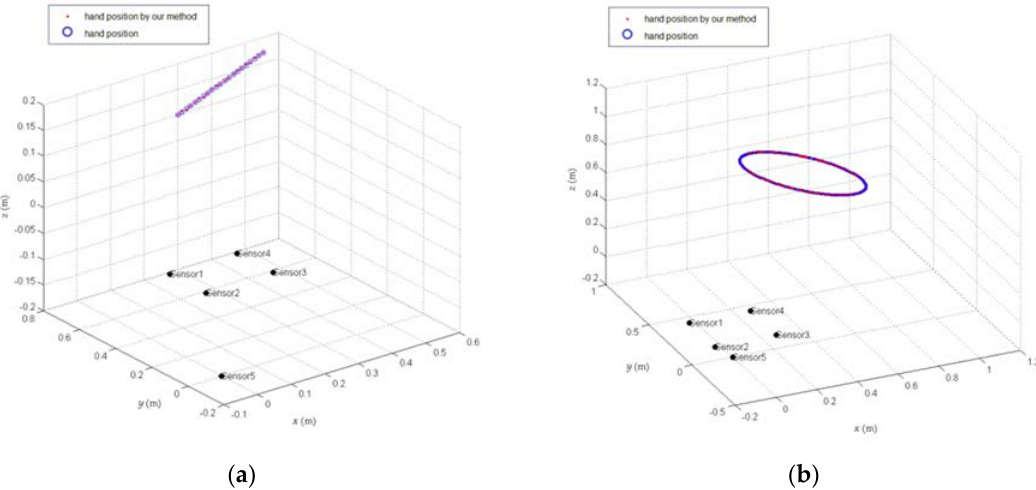
Figure 14. Charge source real ‐ time position solution results for ( a ) a linear trajectory and ( b ) a circular trajectory.